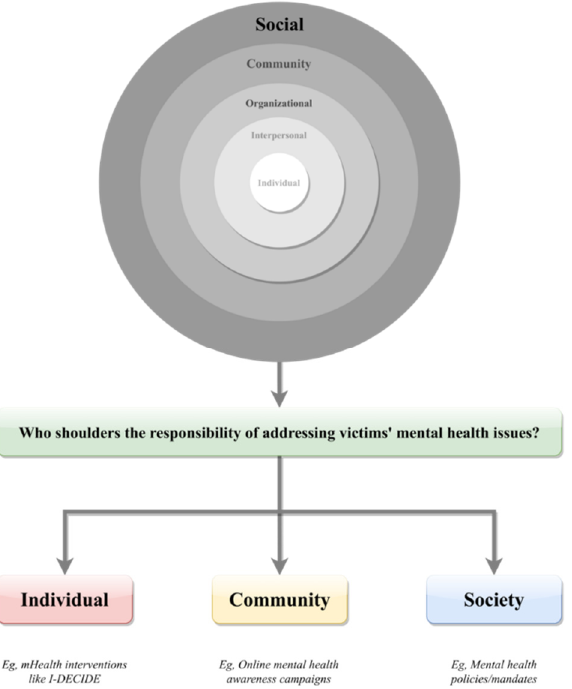
Figure 1. A schematic representation of the modified social ecological model.